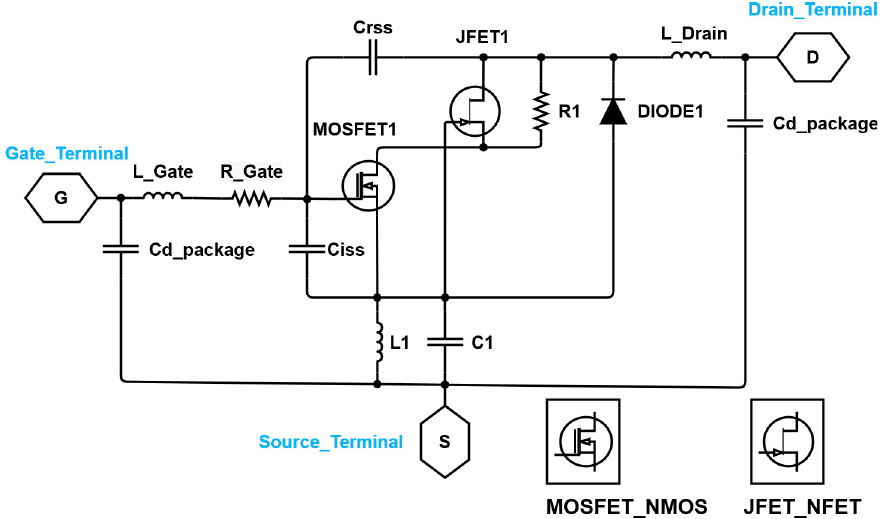
Fig 6. Large-signal LDMOSFET equivalent circuit provided by